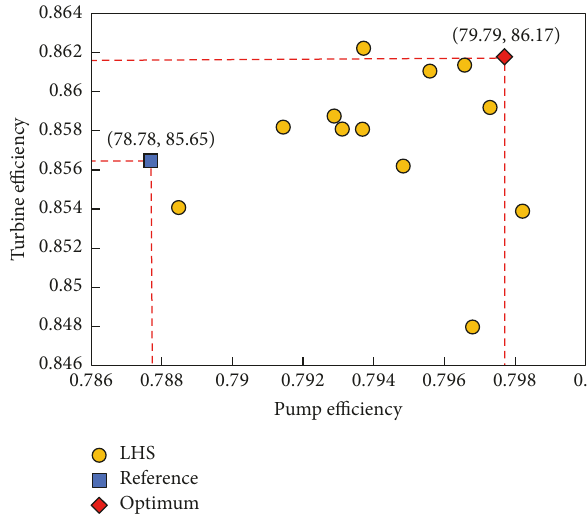
Figure 7: Results of multiobjective optimization.